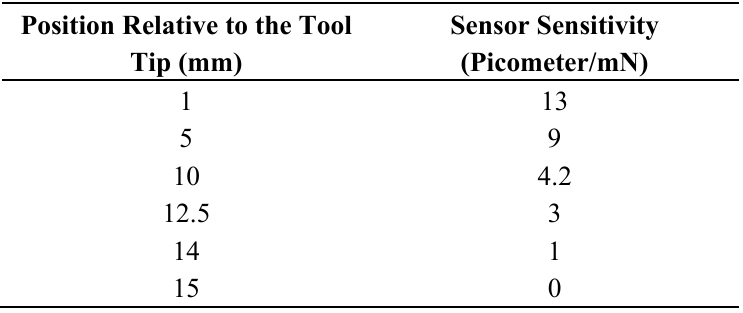
Table 2. Wavelength/Force ratio vs. position along the